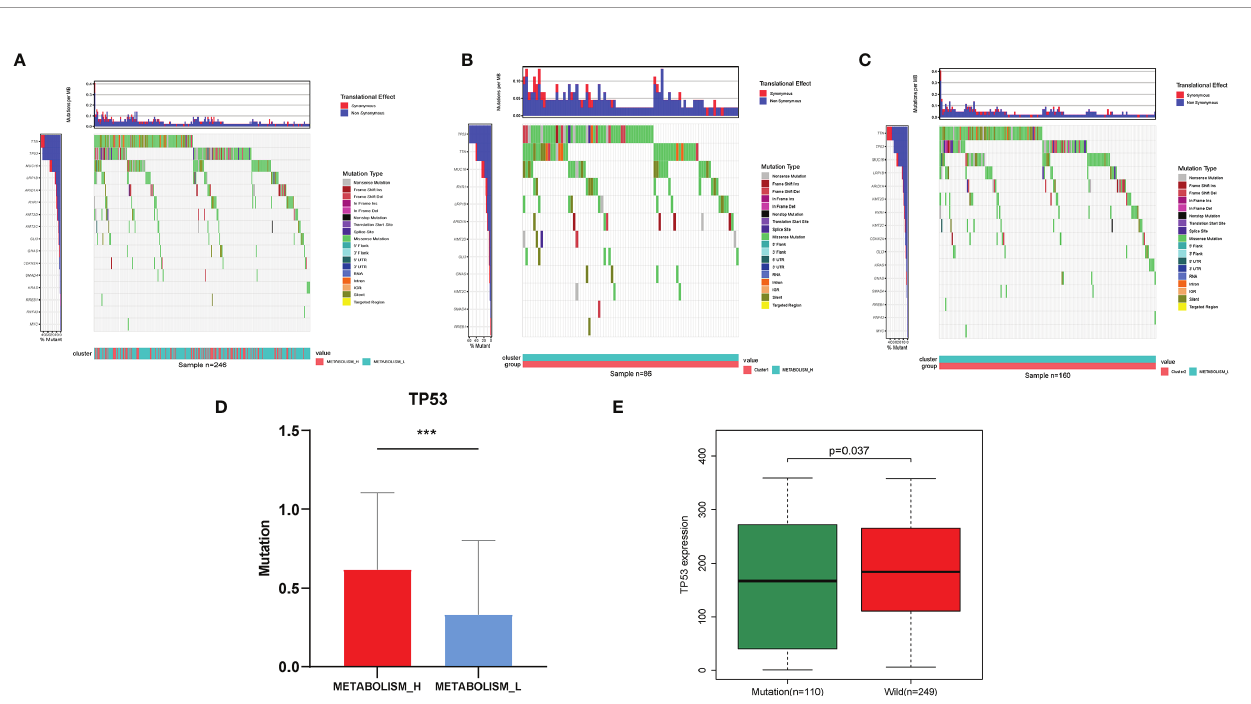
FIGURE 3 | Different mutant oncogenes between HCC Metabolism_H and Metabolism_L. (A) Waterfall plots suggested that TP53 , TTN , and MUC16 were main mutant oncogenes in HCC patients, but they were different between (B) Metabolism_H and (C) Metabolism_L. (D) Metabolism_H was more likely to have TP53 mutations (Student ’ s t -test, p < 0.001). (E) The mutated TP53 gene was less expressed than the wild type (Wilcoxon test, p = 0.037). HCC, hepatocellular carcinoma. *p < 0.05, **p < 0.01, ***p <